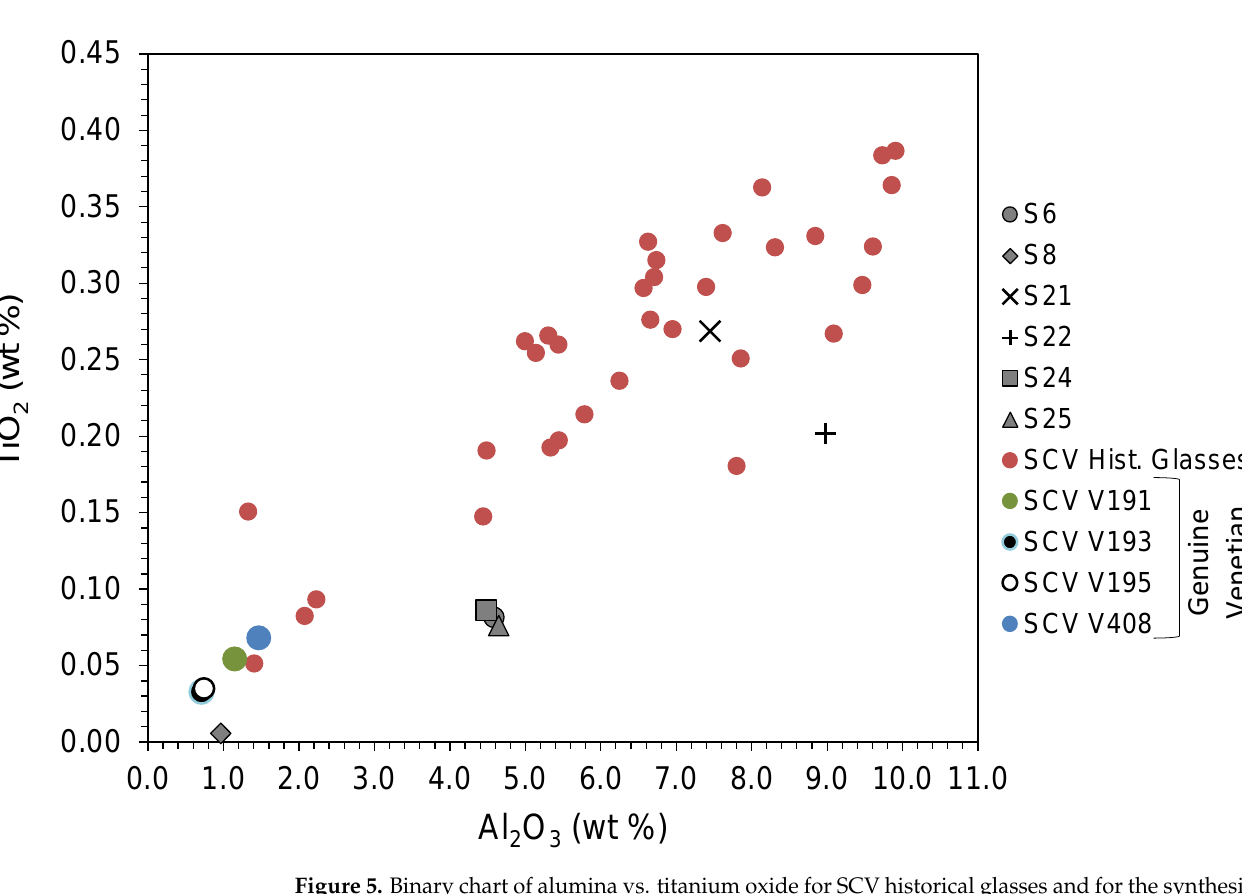
Figure 5. Binary chart of alumina vs. titanium oxide for SCV historical glasses and for the synthesised glasses in weight percent of oxides.